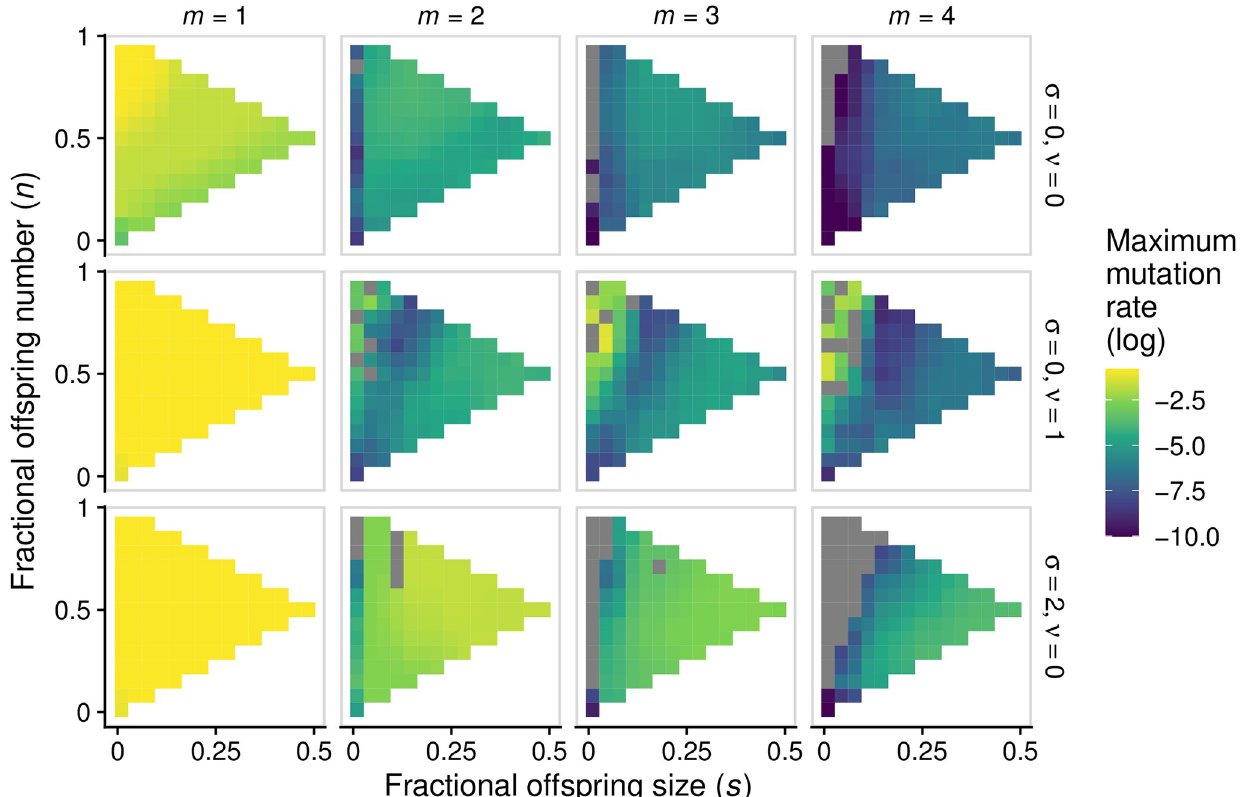
Fig 5. Migration and size-dependent fragmentation rate allow multispecies communities to resist mutational meltdown. Each panel shows, for each position in the strategy space, the maximum mutation rate a population can experience before going extinct (similar to Fig 3E). Columns (from left to right) depict increasing number of species. Rows depict: no size-dependent fragmentation and no migration ( top ); migration and no size-dependent fragmentation ( center ); size-dependent fragmentation and no migration ( bottom ). Grey squares correspond to communities for which the maximum mutation rate is outside the range of our simulations or numerical errors. For each value of mutation rate, we assessed ten replicates per fragmentation mode; we then calculated the mean (across replicates) of the logarithm of maximum mutation rate. Each point in the figure corresponds to a nearest- neighbour average of this quantity. Parameters: all parameters are set to the default values, unless otherwise indicated (Table A in S1 Text). Figs G and H in S4 Text comprise a wider range of values of σ and ν and depict raw values of maximum mutation rate (rather than nearest-neighbour averaged values).